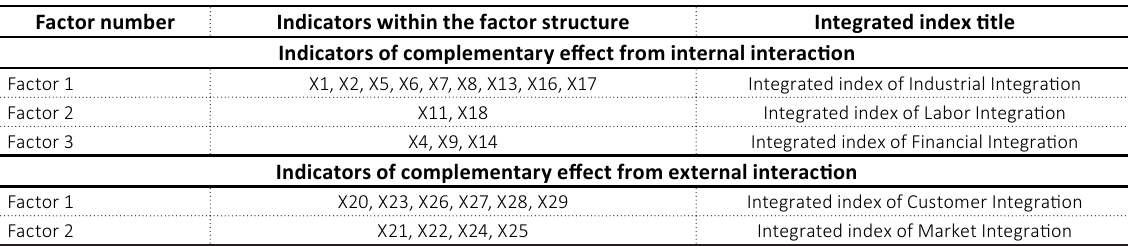
Table 1. A structure of factors and indicators that have significant influence on complementary effect from internal and external